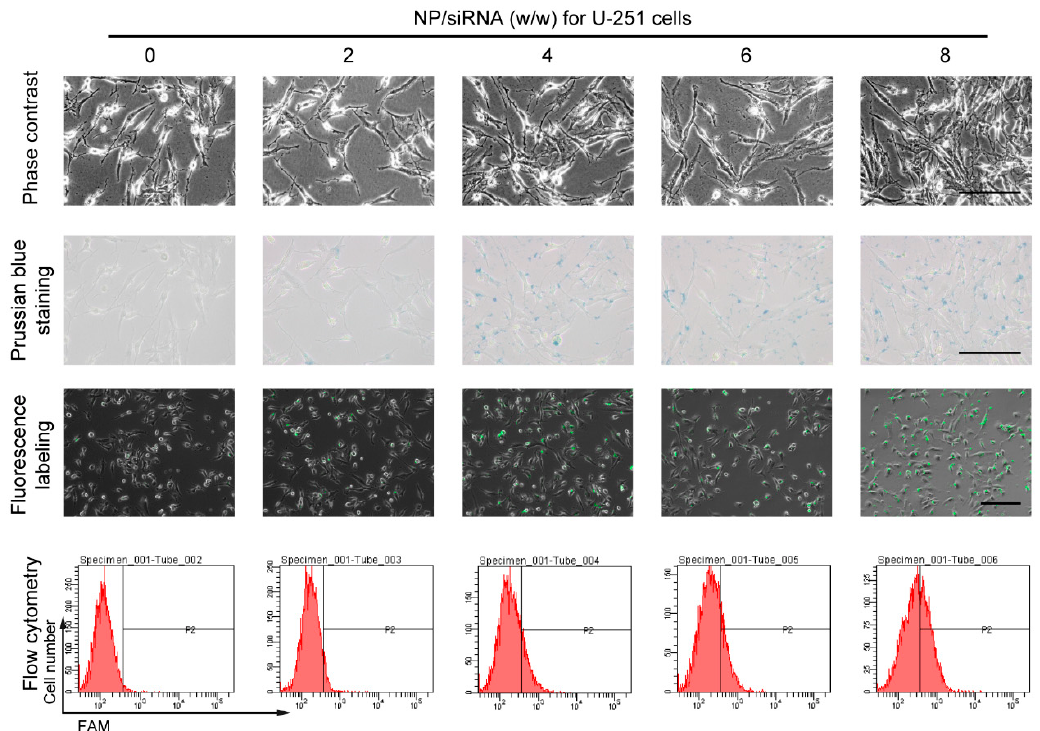
Figure 3. The cellular uptake of the NP/siRNA complexes in U-251 cells. The cellular uptake of the NP/siRNA complexes in U-251 cells was verified by prussian blue staining, fluorescence labeling and flow cytometry, P2 presented positive proportions. Bar indicates 100 μ m.